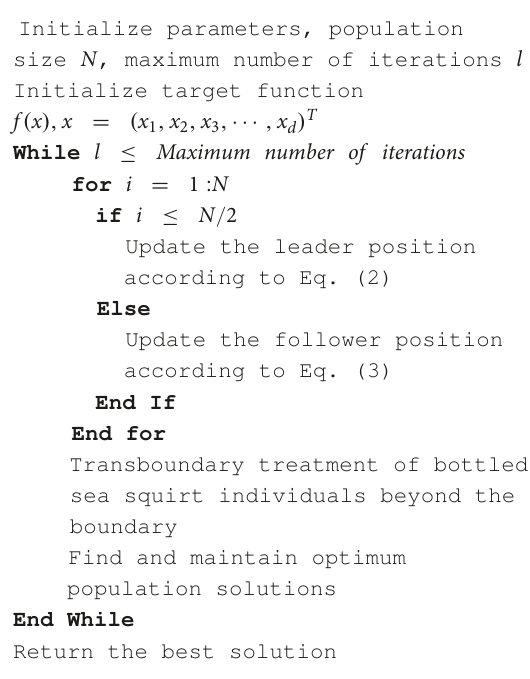
Algorithm 2. Pseudo-code of